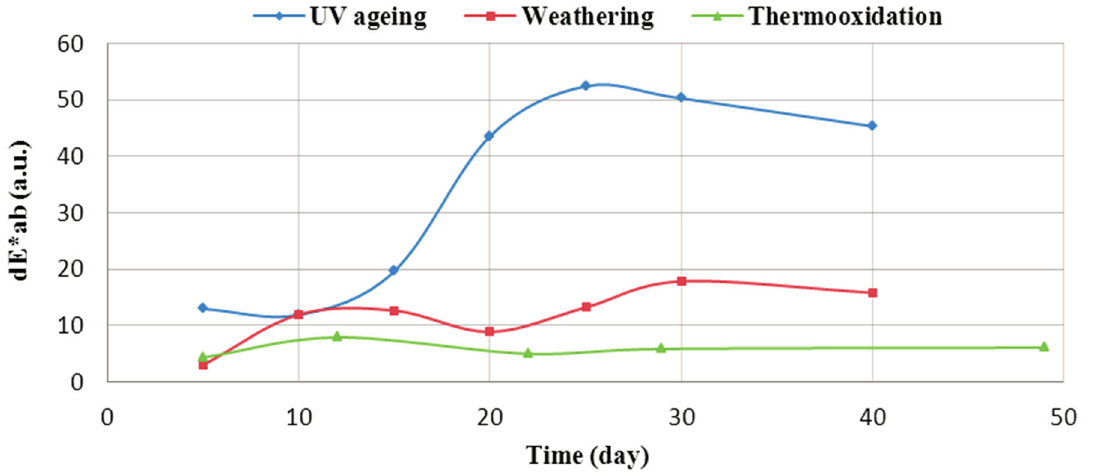
Figure 10. Effect of silymarin (10%) on the color of the EPM material in ageing time tests. The d E * ab index ( Δ E * = ( Δ L * 2 + Δ a * 2 + Δ b * 2 ) 1/2 ) was tested in the CIE-Lab coordinate space, with Δ L * as the degree of lightness difference, Δ a * being the red/green difference, Δ b * being the yellow/blue difference.